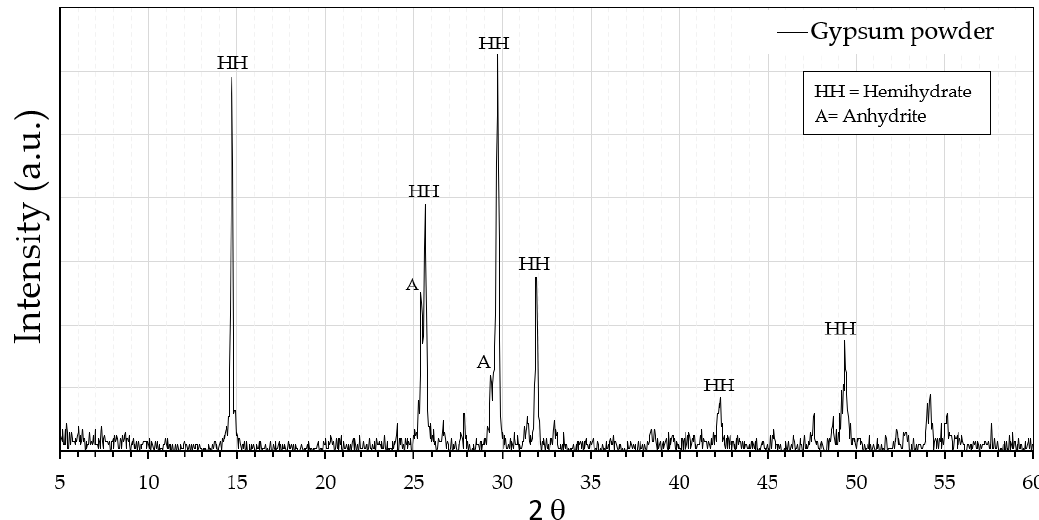
Figure 2. Analysis by X-ray diffraction (XRD) of the gypsum powder.